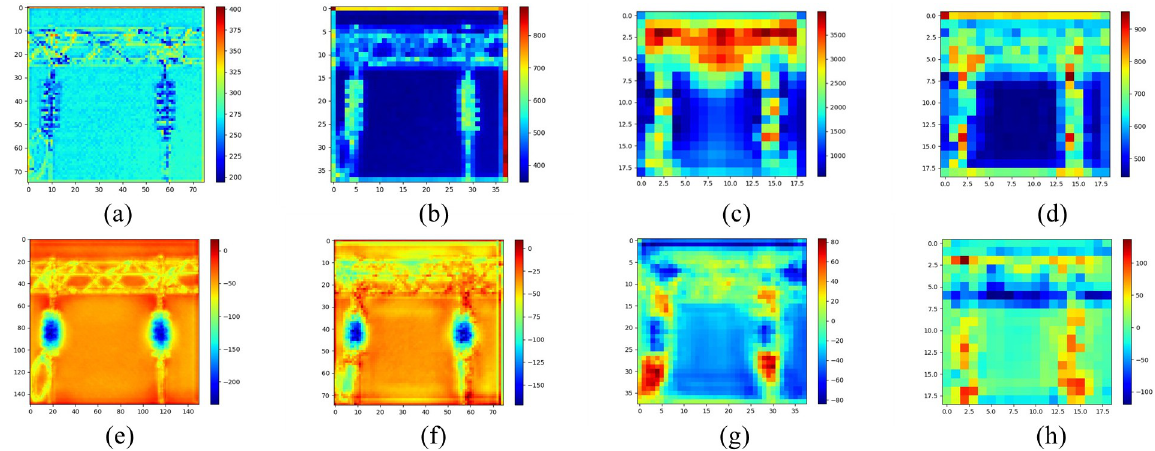
Fig 8. Visualization of convolution process in model training. (a)C2 layer (b)C3 layer (c)C4 layer (d)C5 layer (e)P2 layer (f)P3 layer (g)P4 layer (h)P5 layer. Fig (a) to (d) is the process of down-sampling the feature map. As the down-sampling progresses, the detailed features of the image begin to become blurred, and the semantic features are enhanced. Fig (h) to Fig (e) is the process of sampling on the feature map. With the fusion of P5C5, P4C4, P3C3, P2C2 to P1C1, the semantic features of the feature map are enhanced while the detailed features are also improved. In the end, we got a feature map with strong semantic features and detailed features in the P2 layer.